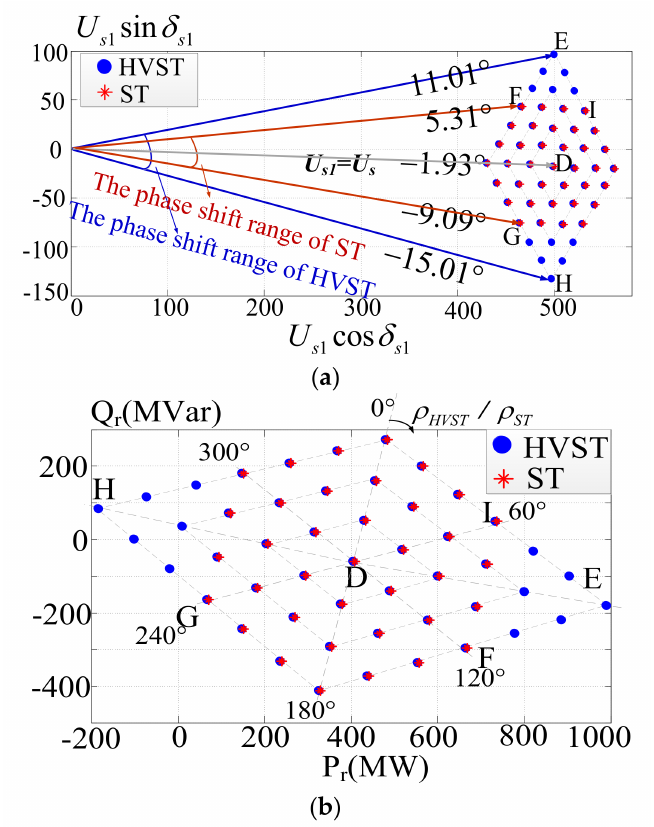
Figure 10. The steady-state simulation results of the ST and the HVST. ( a ) The compensated sending-end voltage U s1 ; ( b ) The relationship between the active and reactive power flows P r and Q r